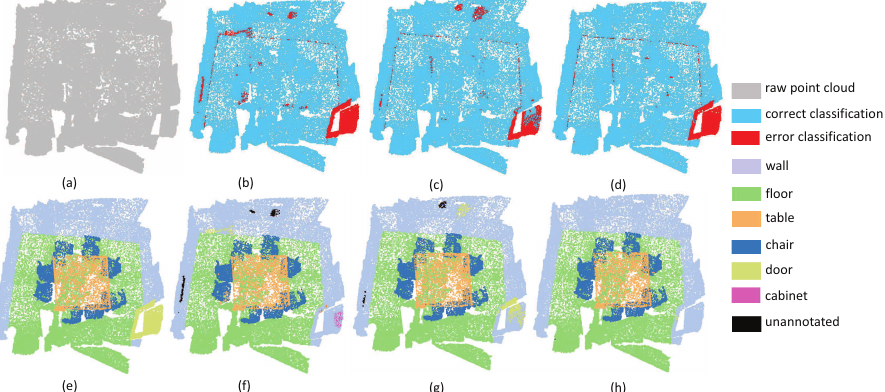
Figure 10. The edge segmentation results on ConferenceRoom . ( a ) input, ( e ) ground truth, ( b , f ) the classification result by PointNet++, ( c , g ) the classification result by PointSIFT, and ( d , h ) the classification result by